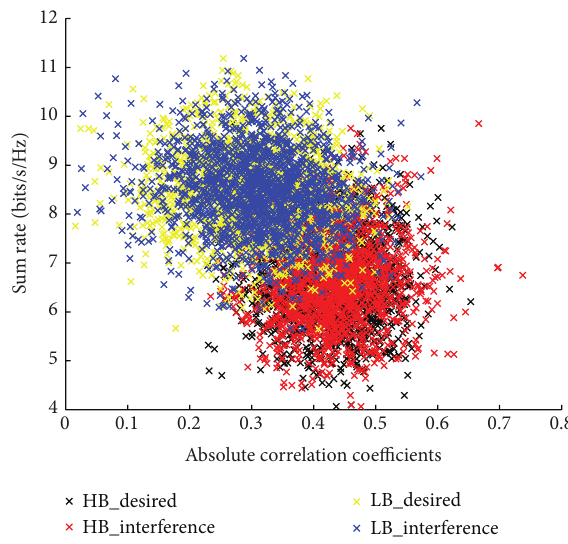
Figure 13: Scatter plot: capacity versus correlation for desired and interference links at low and high